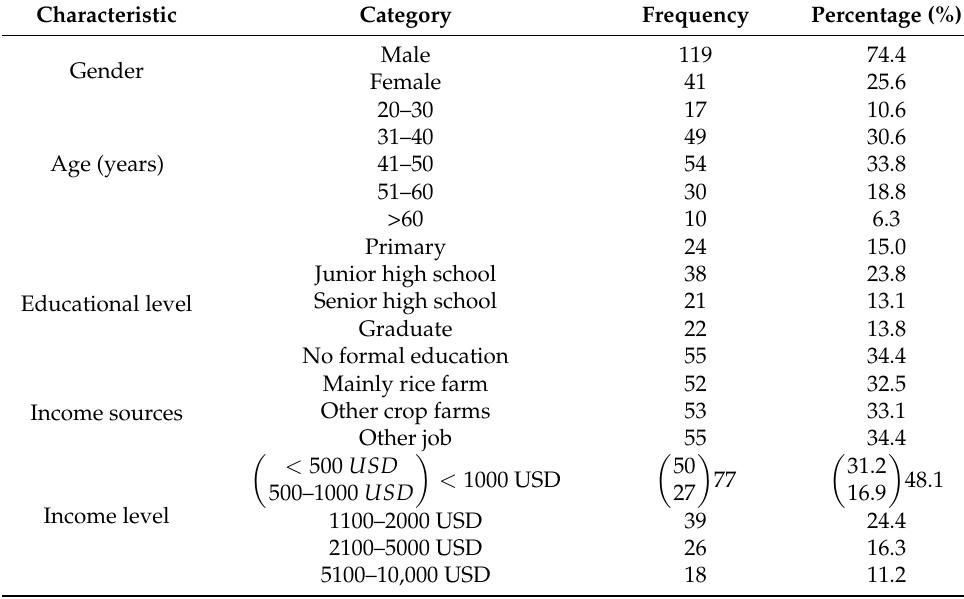
Table 2. Sociodemographic characteristics of respondents.